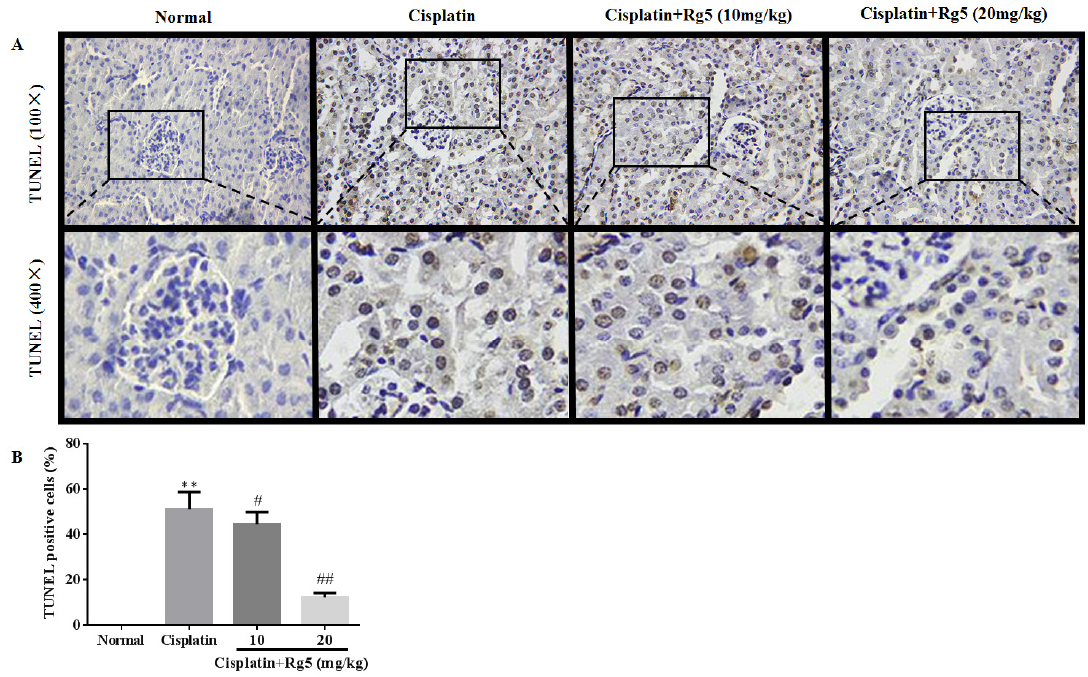
Figure 8. Histological examination of morphological changes in kidney tissues. Renal tissues stained with TUNEL (100× & 400×) ( A ). The presence of TUNEL positive cells were measured by the image analyzer ( B ). All data were expressed as mean ± S.D., n = 8. ** p < 0.01 vs. normal group; # p < 0.05, ## p < 0.01 vs. cisplatin group.